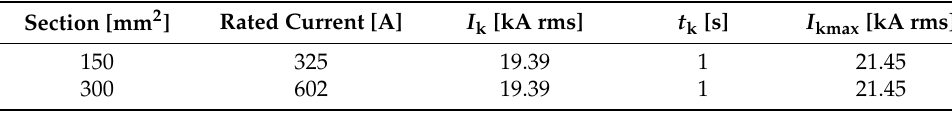
Table 15. Electrical data assumed for 6 kV